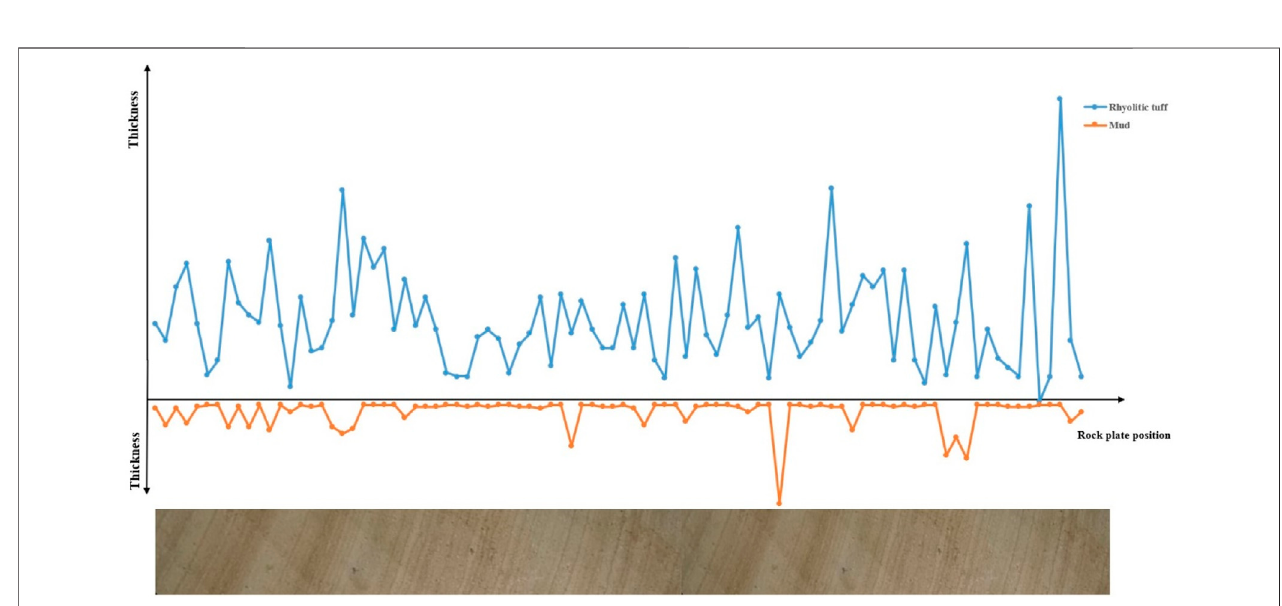
FIGURE 5 | Lithologic line chart of the Lingshan Island sample and whole-rock plate.